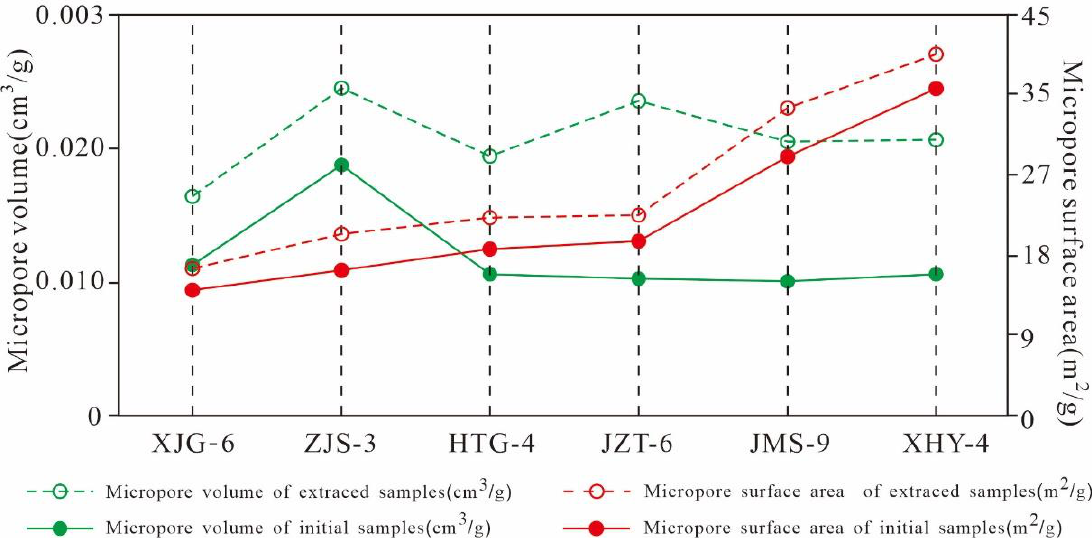
Figure 21. Micropore SA and PV variation characteristics of the original shale and its corresponding extracted samples.